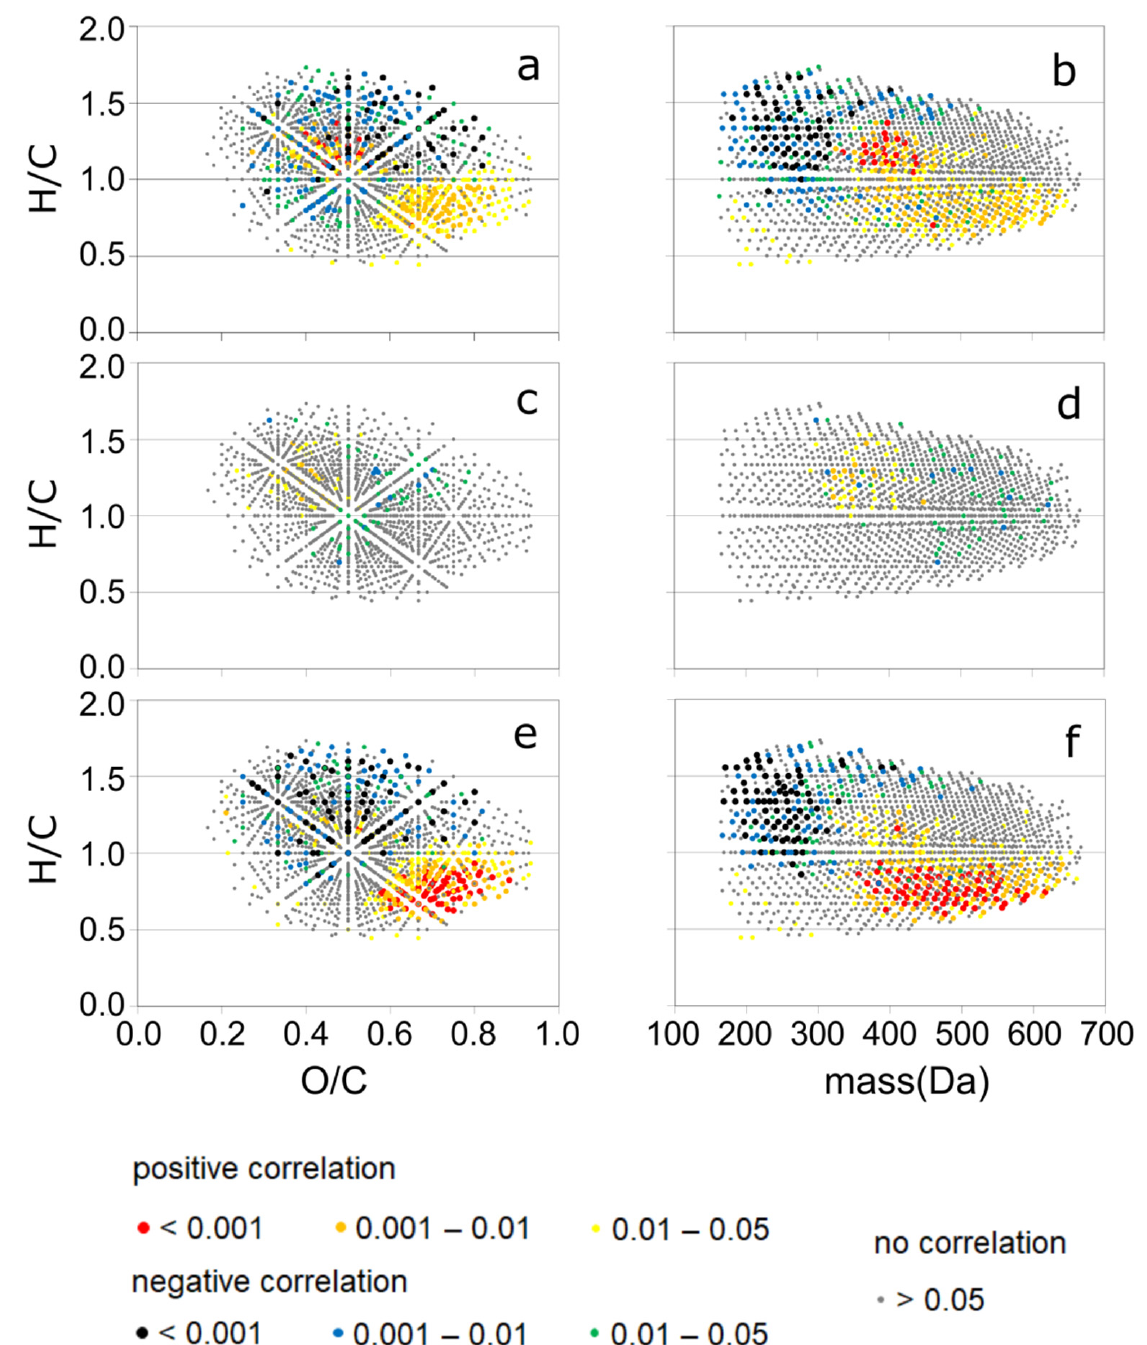
Figure 9. Spearman’s rank correlations between relative intensities of molecular formulas (MFs) and HIX ( a , b ), BIX ( c , d ), and FI ( e , f ) of all CHO-MF found in all 48 samples. The legend shows positive and negative correlations and MFs with no correlations ( p > 0.05) and different p -values ( p < 0.001; 0.001 < p < 0.01 and 0.01 < p < 0.05).